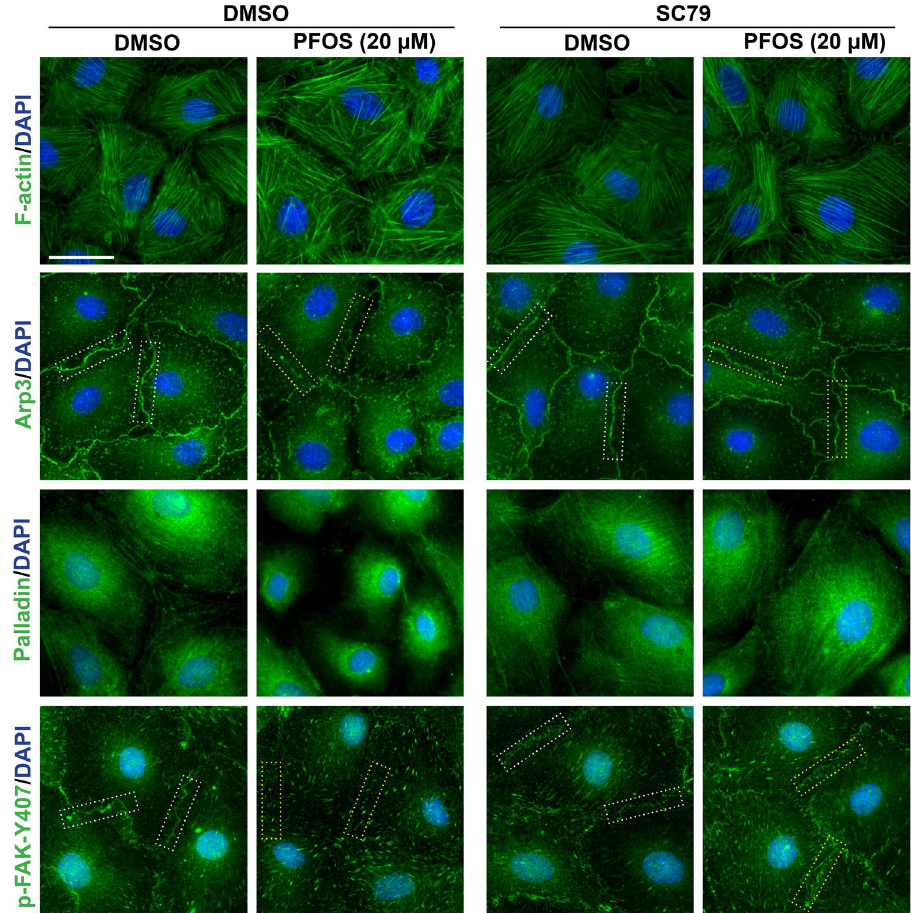
Figure 4. SC79 blocks PFOS-induced disorganization of actin microfilaments by maintaining proper spatial expression of actin regulatory proteins in Sertoli cells exposed to PFOS. Sertoli cells cultured at 0.03 × 10 6 cells/ cm 2 for 3 days were pre-treated with 2 μ g/ml SC79 (5.5 µ M) for 30 min, and then cells were rinsed and treated with 20 μ M PFOS for 24 hr. Cells were then fixed and visualized by immunofluorescence microscopy. It was noted that Sertoli cells exposed to PFOS without pre-treatment with SC79 were grossly disorganized in which actin microfilaments were truncated, likely the result of changes in the spatial expression of Arp3 (a branched actin polymerization protein), palladin (an actin cross-linking and bundling protein) and p-FAK-Y407 (a BTB-associated signaling protein known to promote BTB integrity 14 ). However, pretreatment of Sertoli cells with SC79 blocked the PFOS-induced disorganization of actin microfilaments, causing actin microfilaments to be organized similar to control cells even in the presence of PFOS for 24 hr. This blocking effect of SC79 on PFOS-induced Sertoli cell injury apparently was mediated by maintaining the proper spatial expression of Arp3, palladin and p-FAK-Y407 as noted in control cells. Distribution of the target proteins Arp3 and p-FAK-Y407 at the cell cortical zone was also quantified by measuring the fluorescence intensity at the Sertoli cell-cell interface (see dotted white rectangles in control cells vs . dotted yellow rectangles in PFOS-treated cells), which was the average of 4 measurements (i.e., fluorescence intensity) at two opposite ends of a Sertoli cell as annotated by the rectangles for each cell. About 70 randomly selected cells in each experiment were quantified with n = 3 independent experiments. Scale bar, 30 μ m, which applies to all other